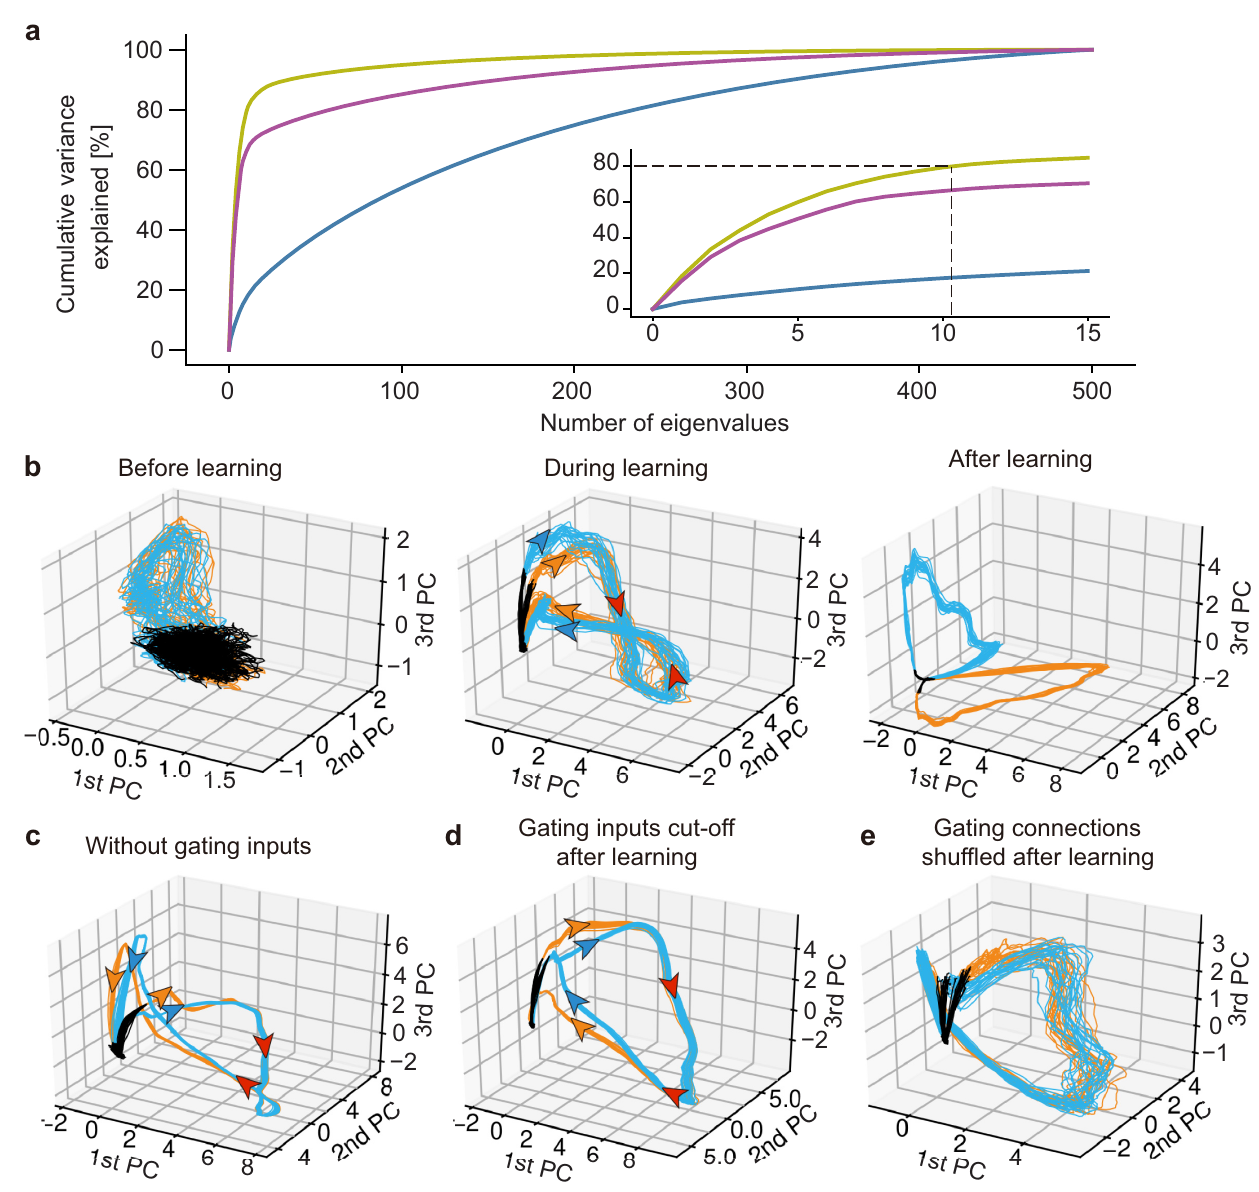
Fig 4. Principal component analysis of the trained network. (a) Cumulative variance explained of the PCs of the activities of before (blue), during (purple), and after (yellow) learning. Inset is an expanded view for major eigenstates. (b) The PCA-projected trajectories of network activity before, during, and after training are shown in the space spanned by PC1 to PC3. The network was trained with the same task as in Fig 2. The black, orange, and blue trajectories represent the periods during which random spike input, chunk 1 and chunk 2 were presented, respectively. (c) Recurrent gating was fixed in all neurons during the whole simulation. (d) The gating factor was clamped after the network in (b) were trained. (e) Recurrent connections were randomly shuffled after the network in (b) were trained. The directions of state evolution are indicated by arrows along the PCA-projected trajectories. The arrows are colored according to the corresponding chunks on the separated parts of the trajectories while they are colored in red on unseparated parts.